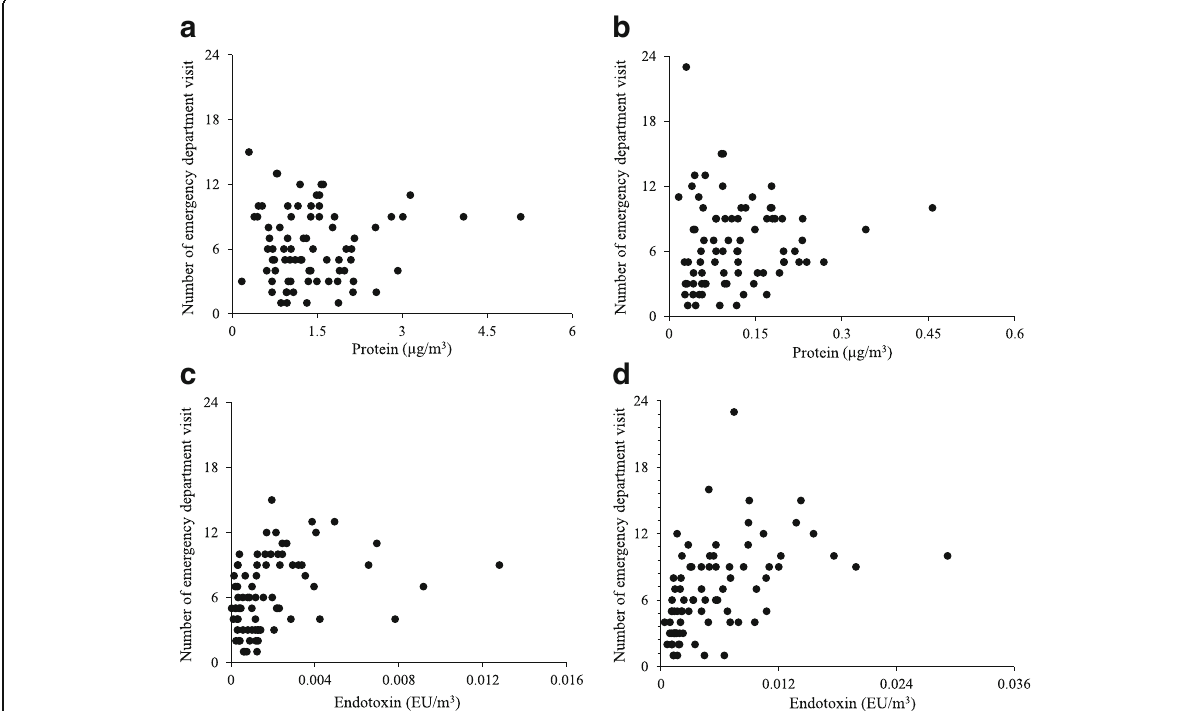
Fig. 2 Scatter plots of protein and endotoxin levels with the number of emergency department visits for asthma. a Protein in fine particles. b Protein in coarse particles. c Endotoxin in fine particles. d Endotoxin in coarse